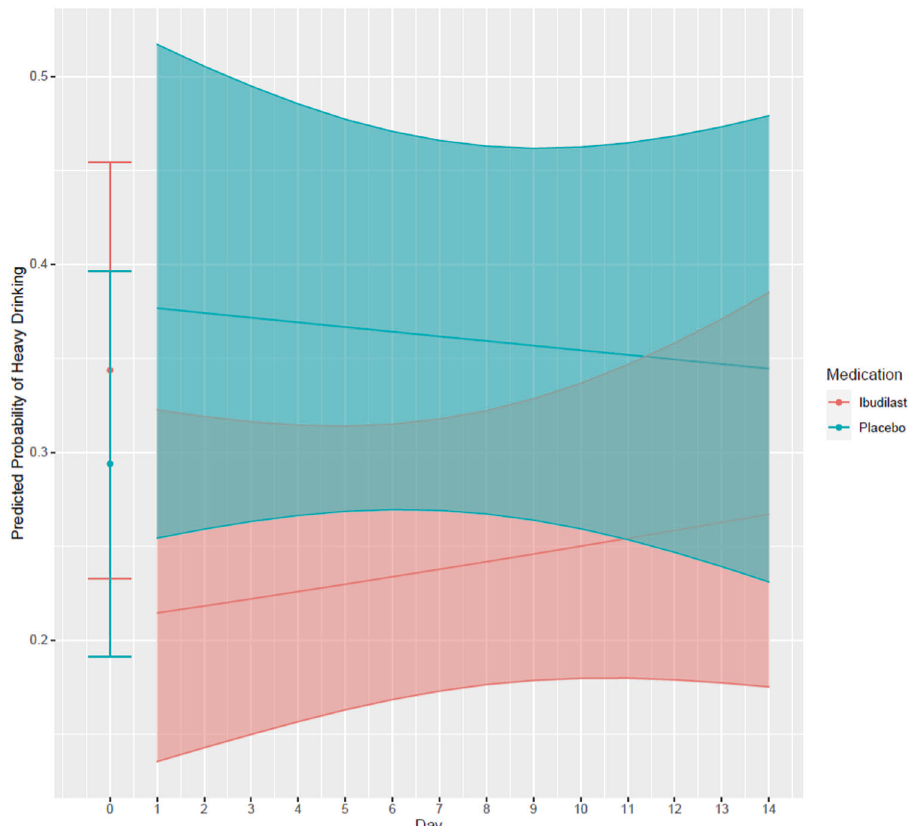
Fig. 2 Effect of ibudilast on heavy drinking days. Ibudilast reduced heavy drinking across time as compared to placebo, controlling for baseline heavy drinking and smoking status. Baseline percent heavy drinking is indicated as Day 0 for each medication group. Heavy drinking is presented as predicted probability of heavy drinking for each day per medication condition in the micro-longitudinal study. The shaded regions are the 95% con fi dence intervals surrounding each